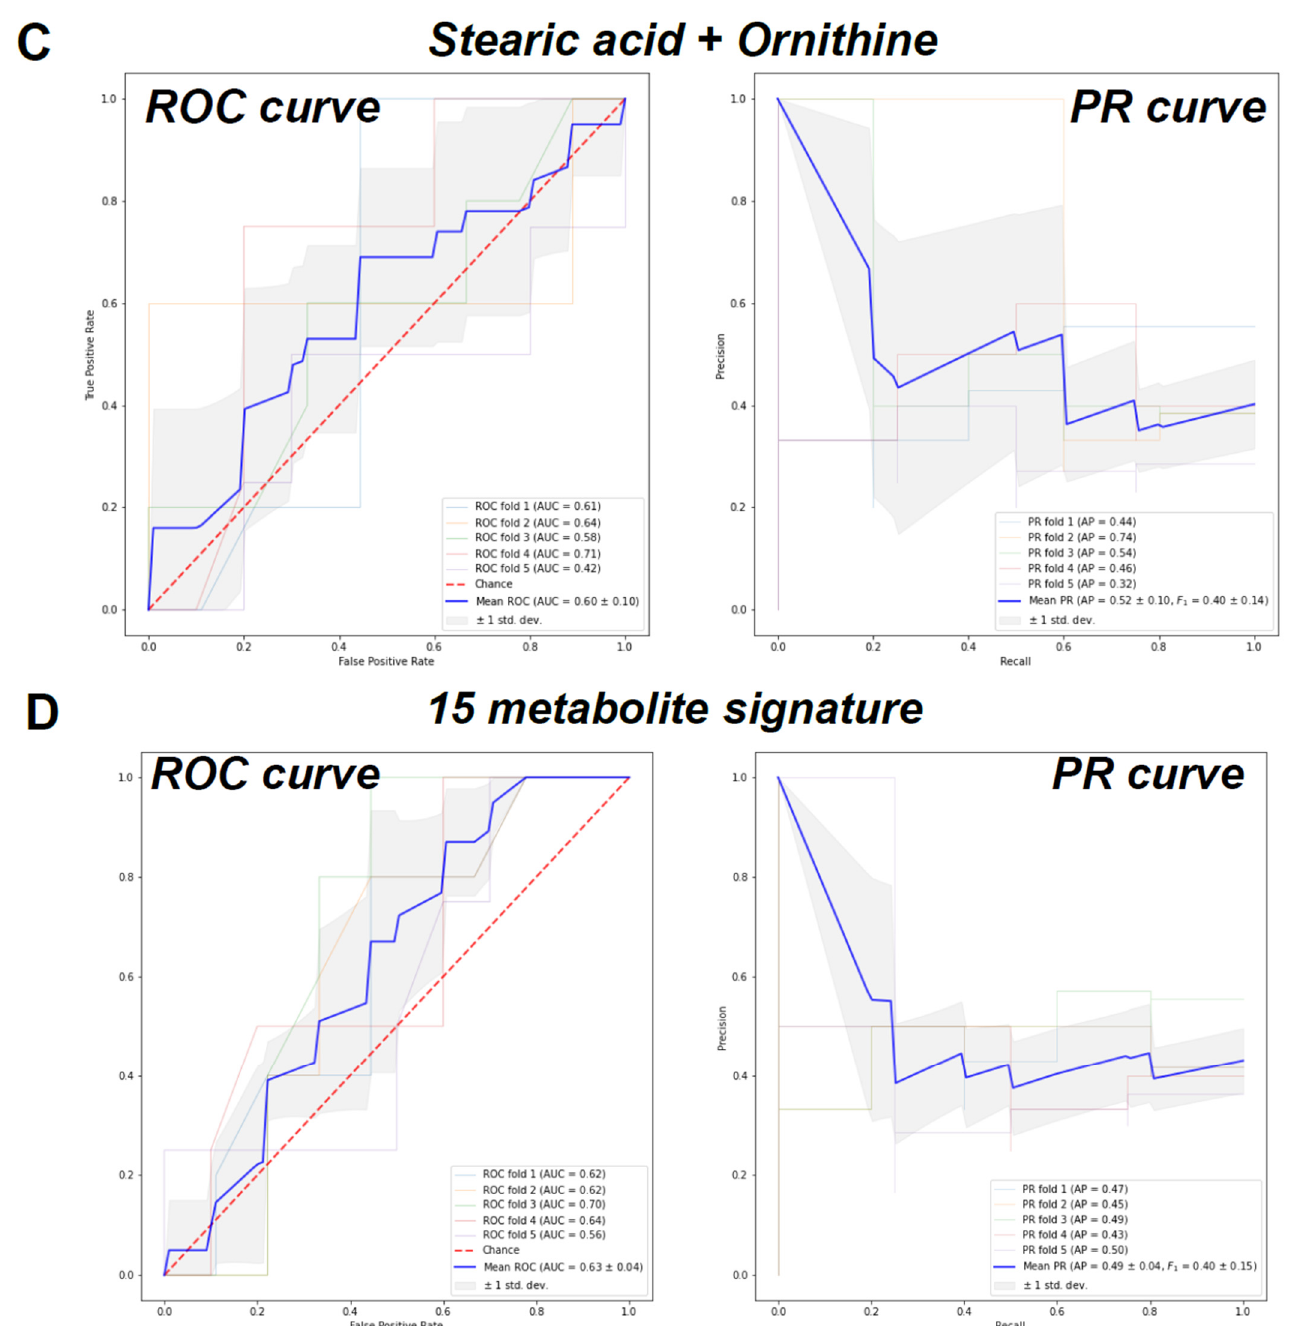
Figure 2. Classification performance validation using ( A ) stearic acid, ( B ) ornithine, ( C ) stearic acid + ornithine and ( D ) 15 metabolite signature.